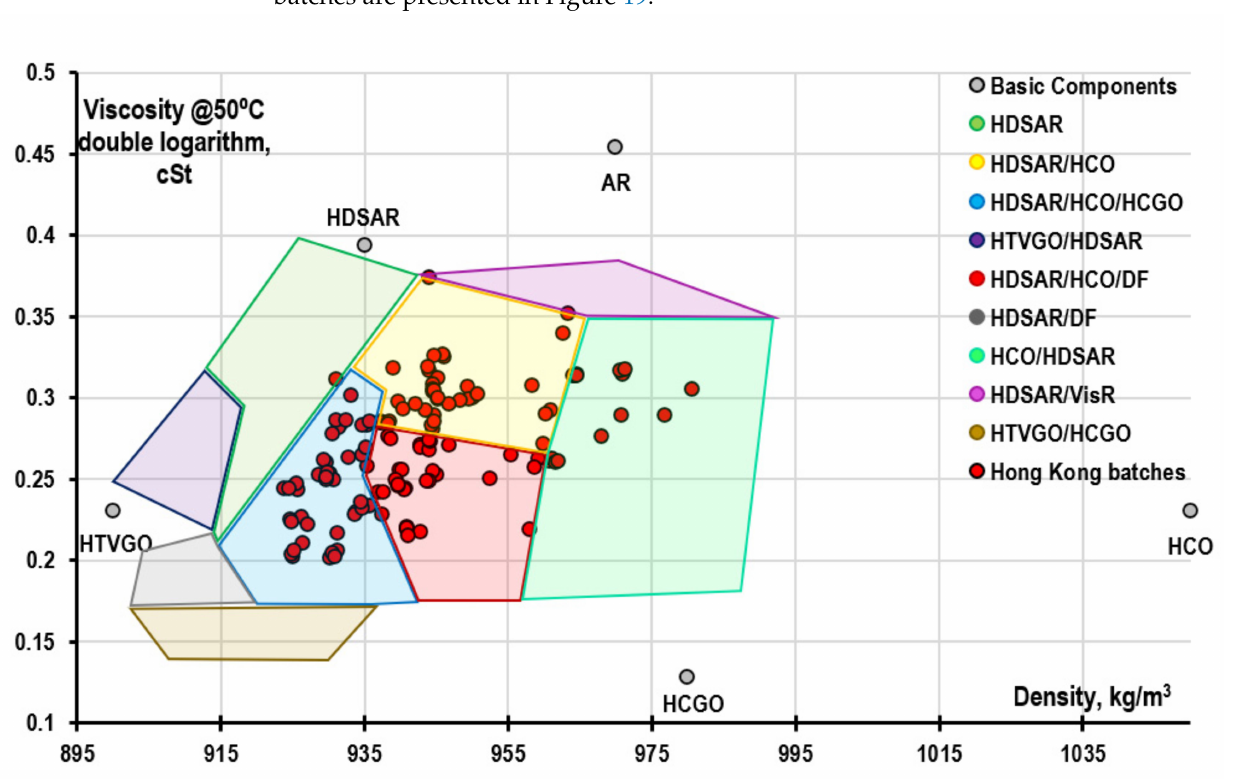
Figure 19. Hong Kong Port parties in logarithmic coordinates